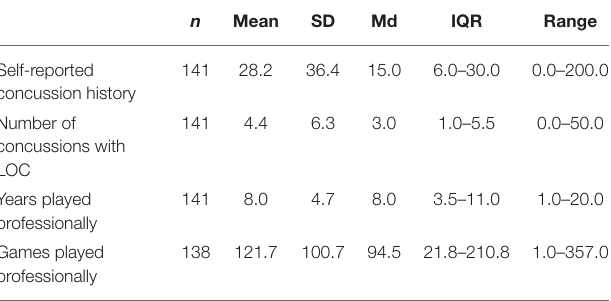
TABLE 4 | Past and present health